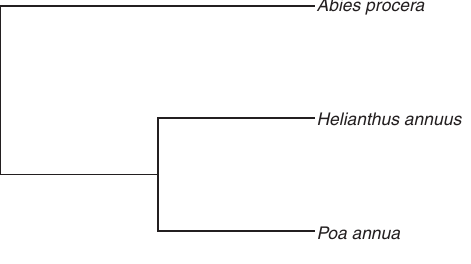
Figure 1. A phylogeny for three species. This phylogeny was produced using the phylomatic_tree function, which queries the Phylomatic database, and prunes a previously created phylogeny of